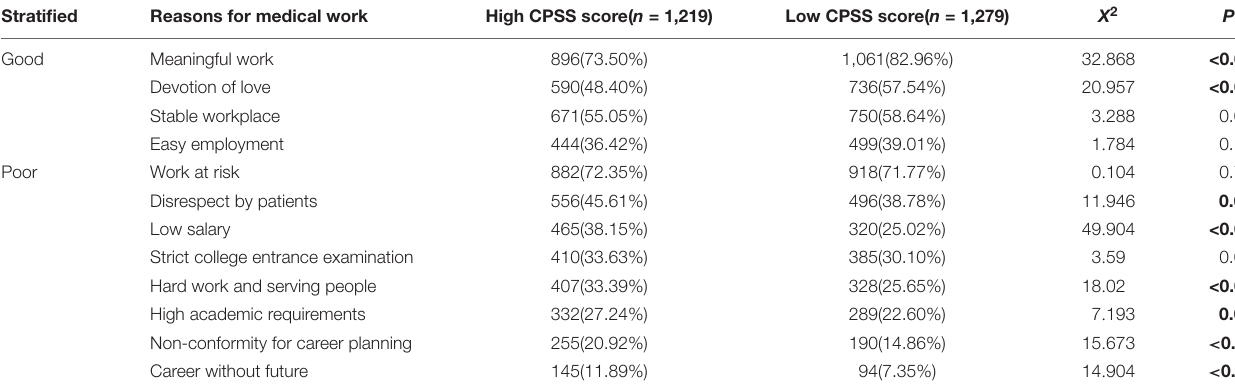
TABLE 3 | The differences of the diverse reasons for choosing the medical career in medical students with high or with low CPSS score.